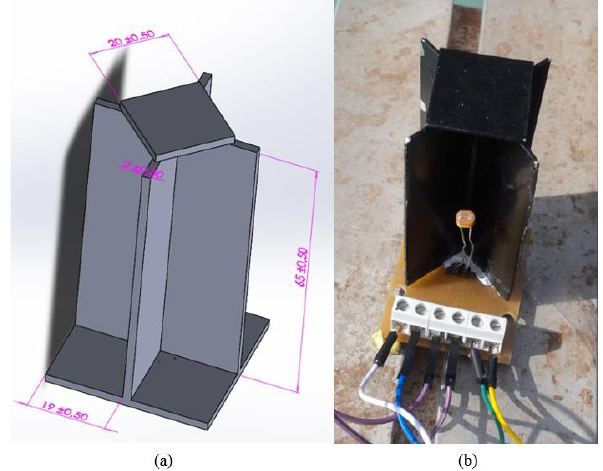
Figure 10. Luminosity sensor: (a) 3D model, (b) prototype.